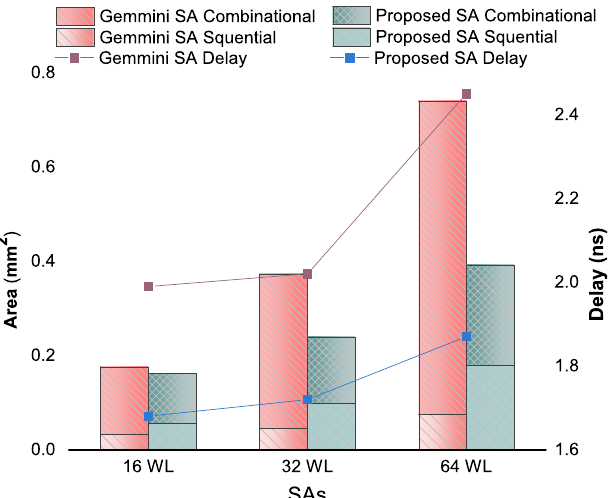
Figure 5. Delay, combinational area and sequantial area comparison of different accumulator wordlength (acc. WL) proposed CPA-Factored Gemmini systolic arrays (SAs) and baseline